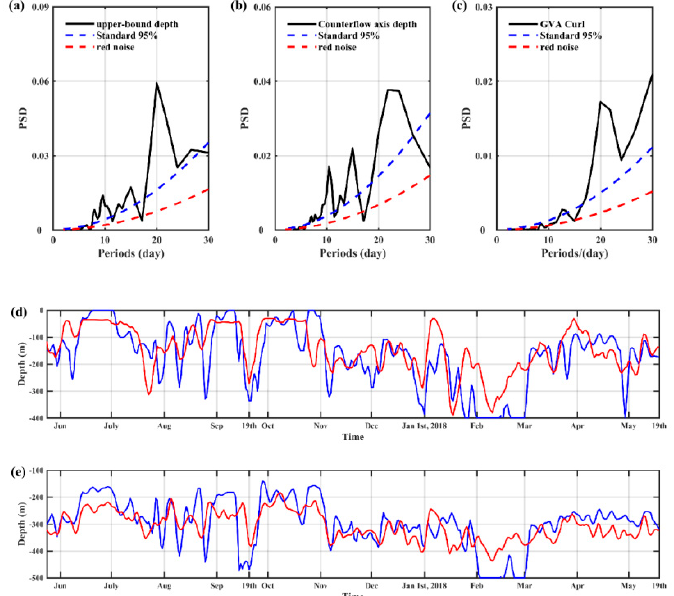
Figure 3. The power spectrum of the observed ( a ) counter-flow upper boundary depth, ( b ) counter-flow axis depth and ( c ) geostrophic velocity anomaly (GVA) curl at the in situ site, and time series of the observed ( d ) counter-flow upper boundary depth and ( e ) counter-flow axis depth. A 5-d filter was applied to the primary data. The red (blue) solid line was derived from in situ observations (analysis data).